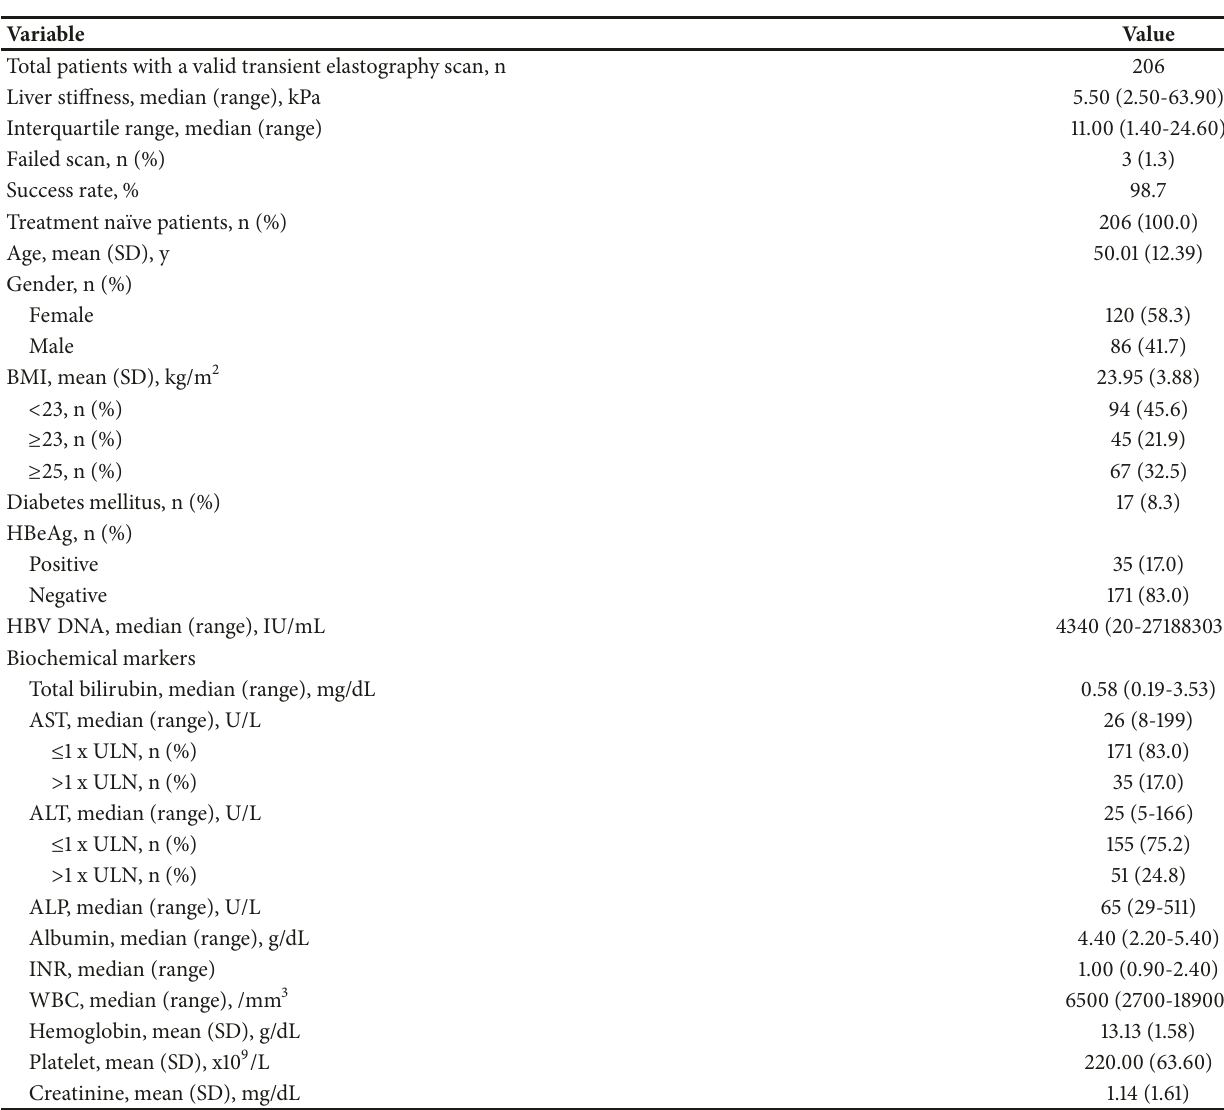
Table 1: Demographic and laboratory data of patients.